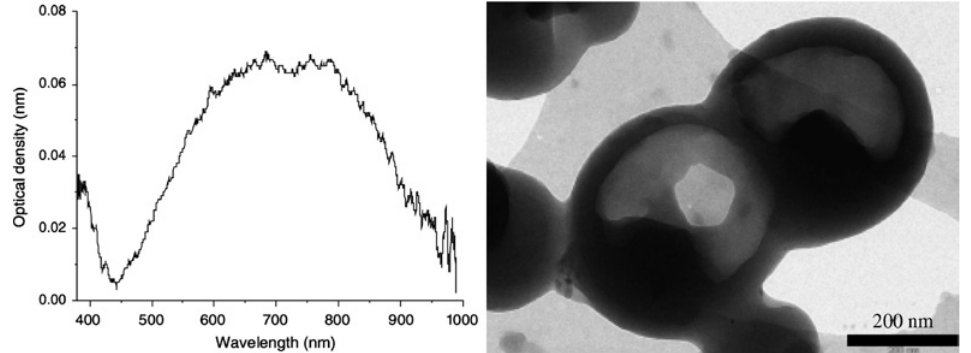
Figure 5: Left: Typical absorption spectrum of single hollow sphere. Right: TEM picture of the particles.